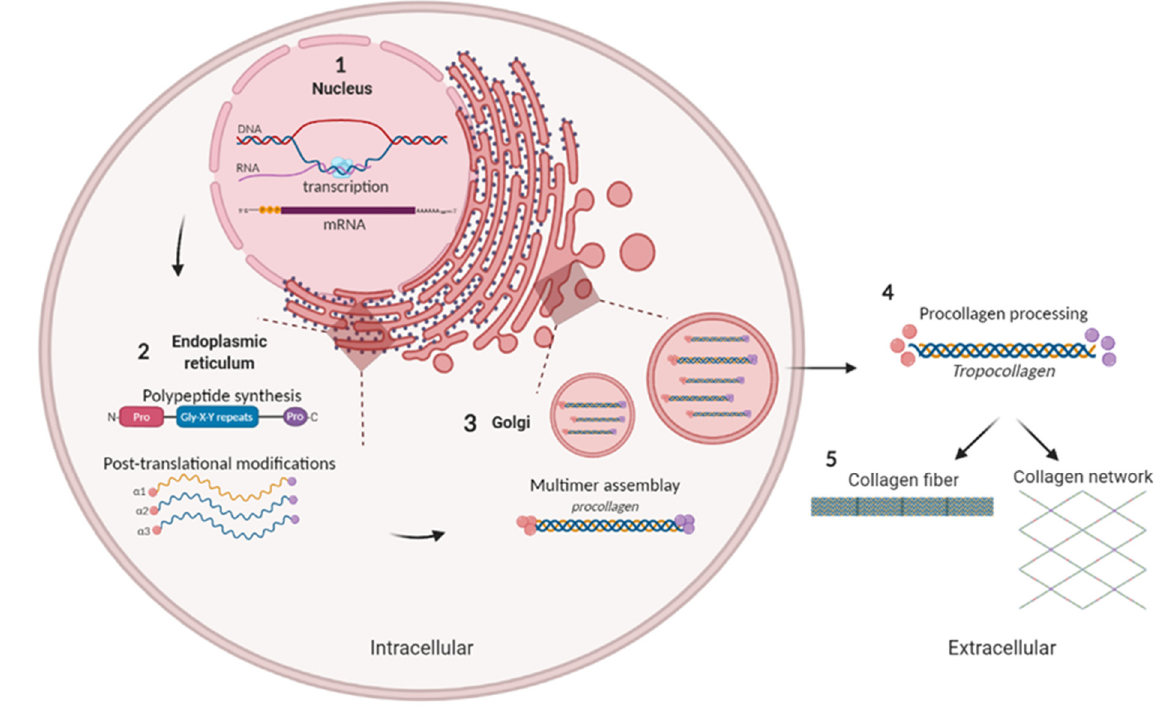
Figure 2. Schematic representation of collagen biosynthesis. (1) Gene transcription. (2) Formation of α -chains. (3) Formation of triple helix procollagen and secretion into extracellular space. (4) Procollagen processing and formation of tropocollagen. (5) Association of tropocollagen molecules to form collagen structures.